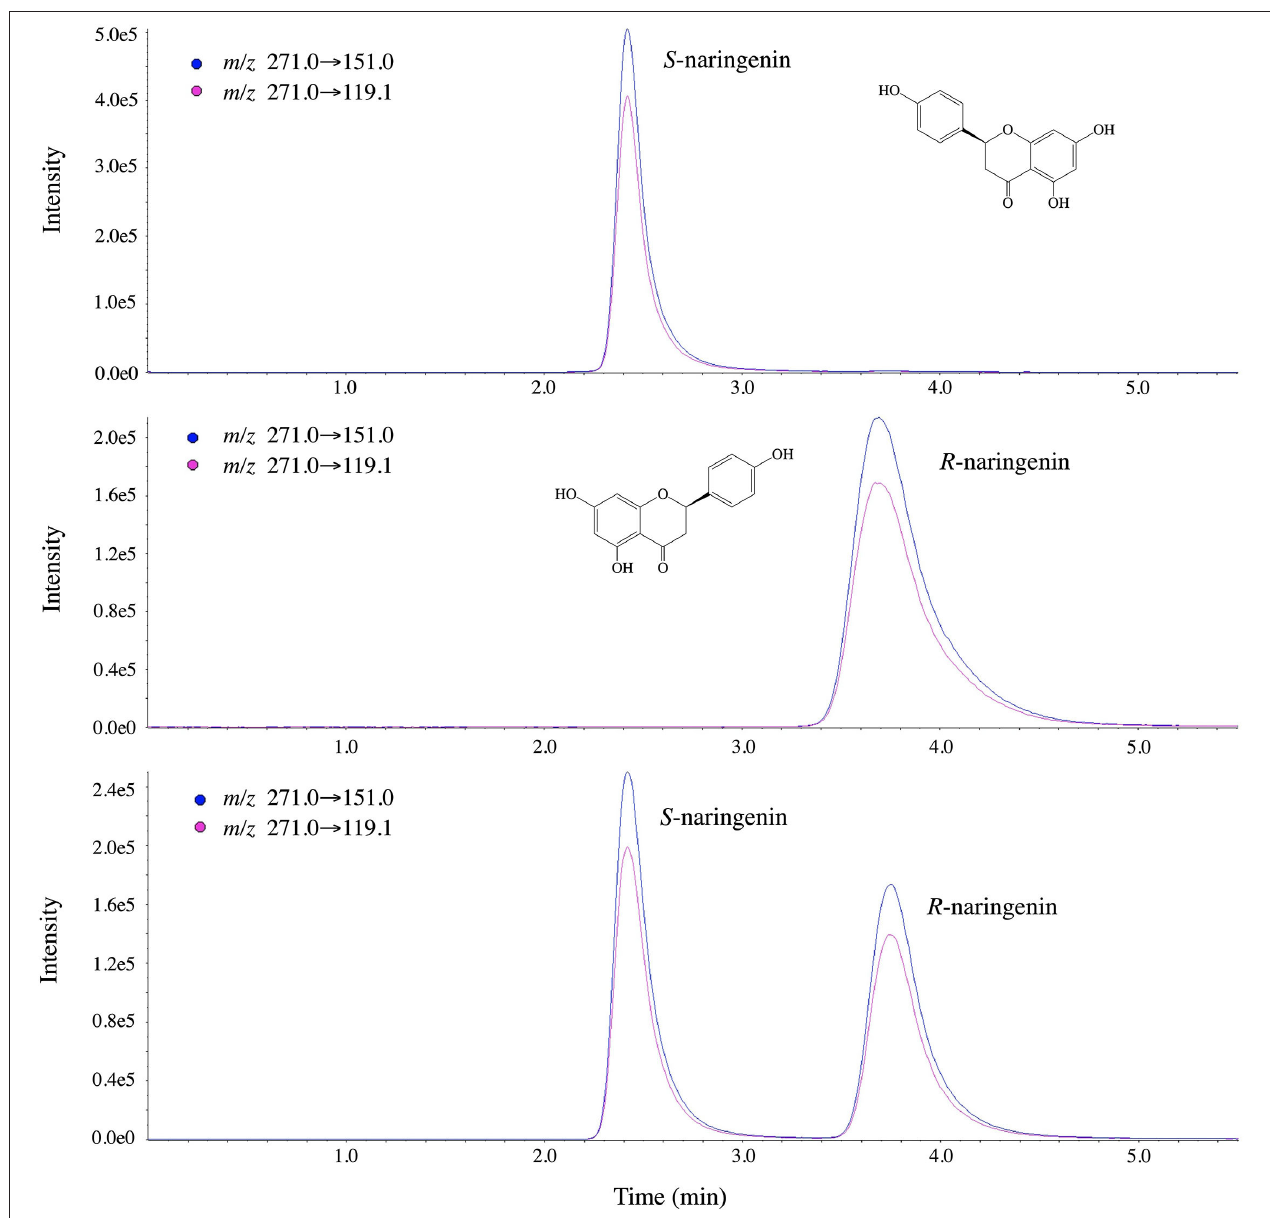
FIGURE 5 | Chromatograms of outflow order of naringenin on IG-3 chiral